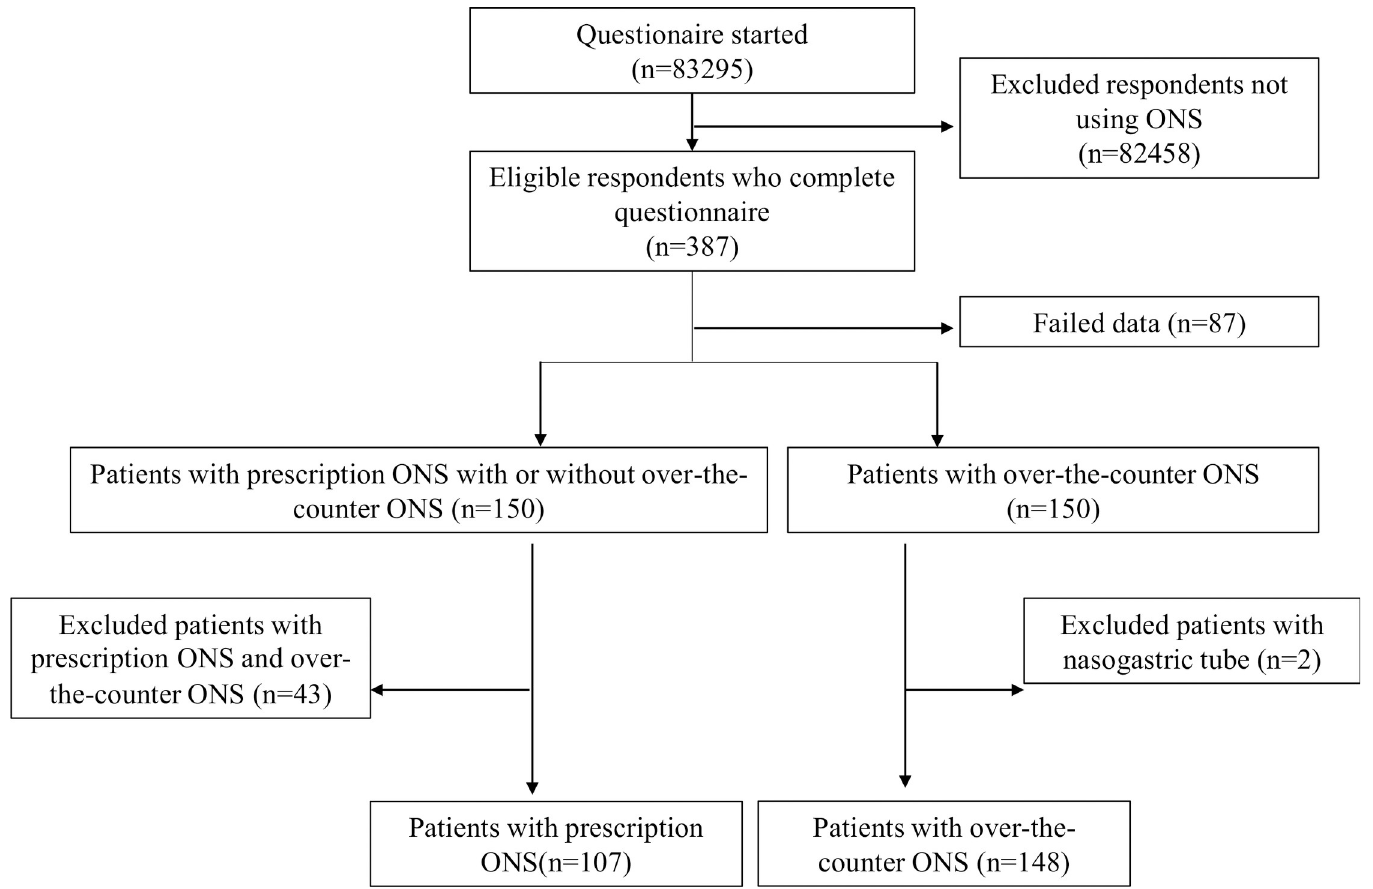
Fig 1. Flow chart of participants in the overall survey.